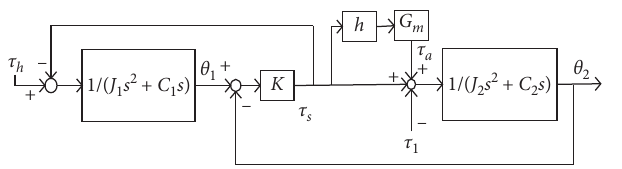
Figure 2: Block diagram of the EPS system.